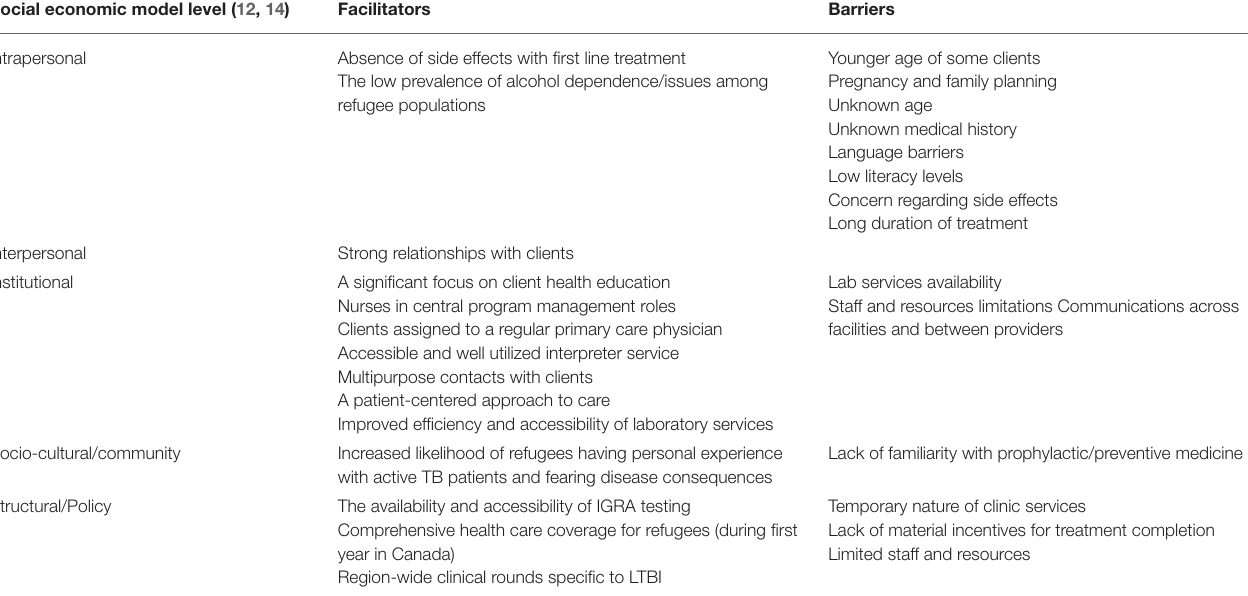
TABLE 4 | Facilitators and barriers to successful LTBI treatment completion for 2015–2016, identified in interviews with staff at BridgeCare